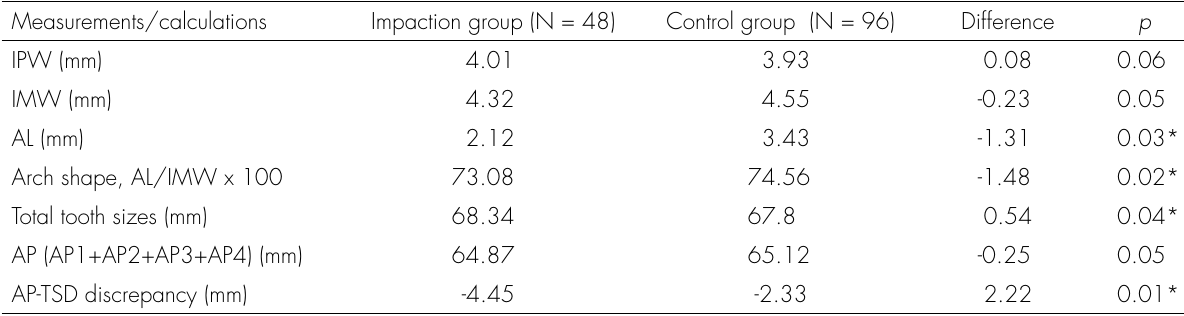
Table II. Inter-group statistical comparison of various measurements/calculations.